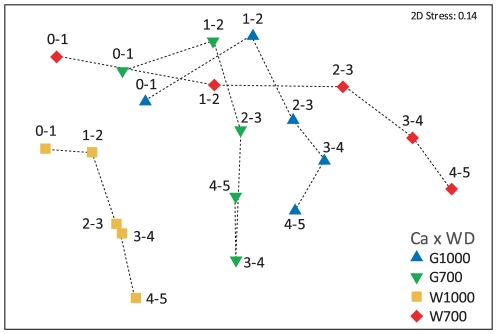
Non-metric MDS plot (Bray Curtis similarity) based on standardised and square-root transformed nematode genera relative abundance data.W700: Whittard 762 m water depth, W1000: Whittard 1160 m water depth, G700: Gollum 755 m water depth, G1000: Gollum 1090 m water depth. Labels denote sediment layer (cm). Dotted lines connect the succeeding sediment layers per station.